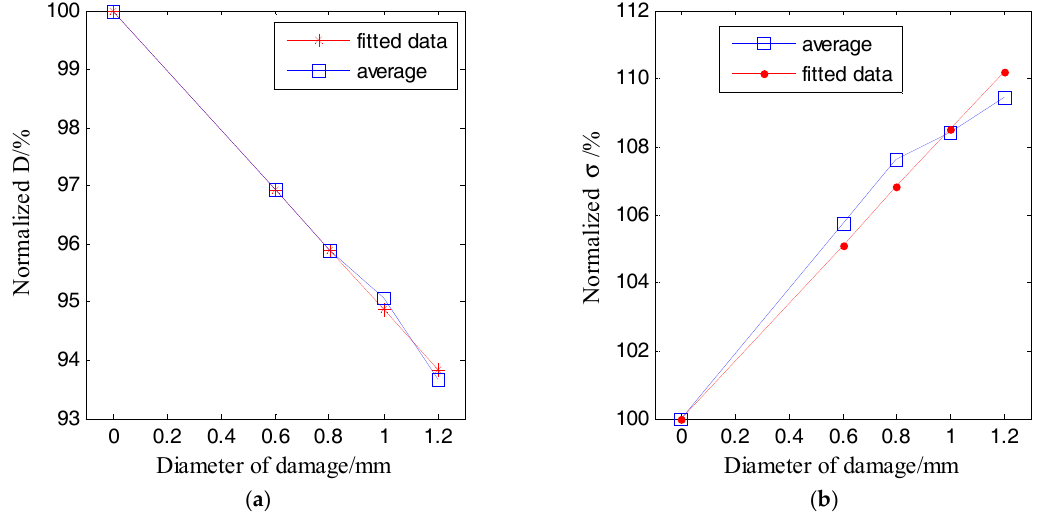
Figure 10. Normalized ultrasonic energy coefficients of damage D1 versus the damage size: ( a ) ultrasound energy diffusion coefficient; ( b ) ultrasonic energy dissipation coefficient.